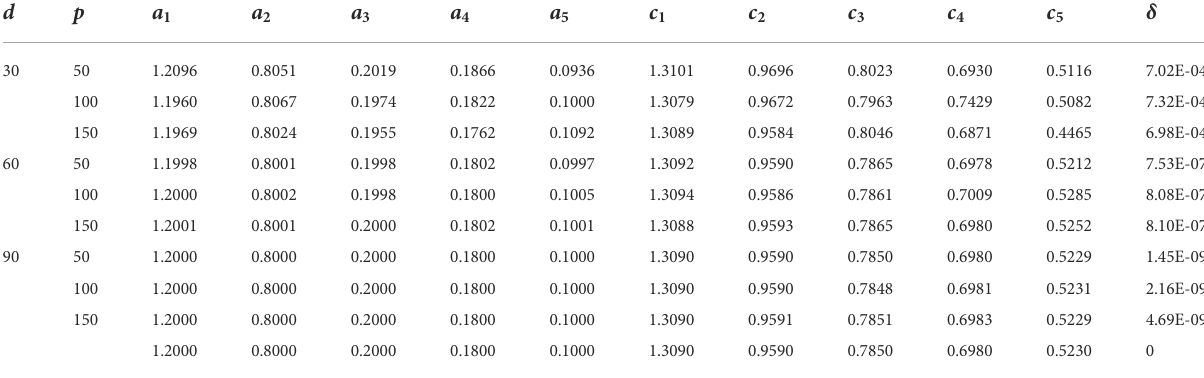
TABLE 6 Results of parameter estimates of Example 2 for G =